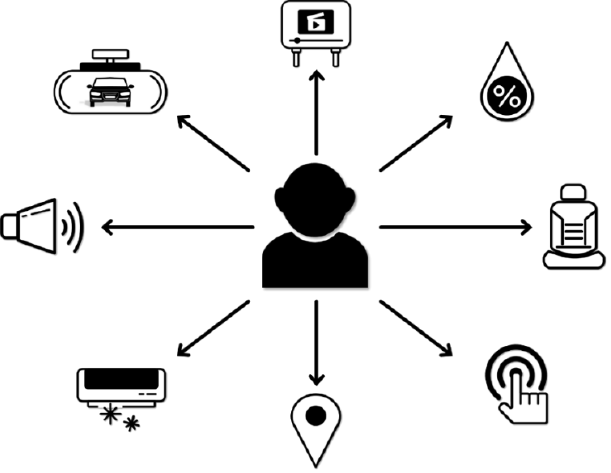
Figure 1. Conventional peer-to-peer In-Vehicle Infotainment (IVI) system .